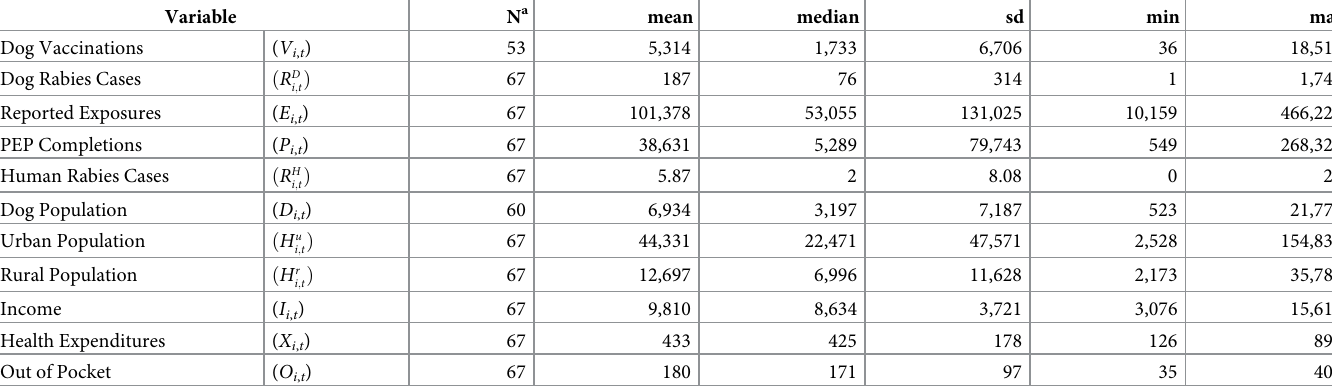
Table 2. Descriptive statistics.